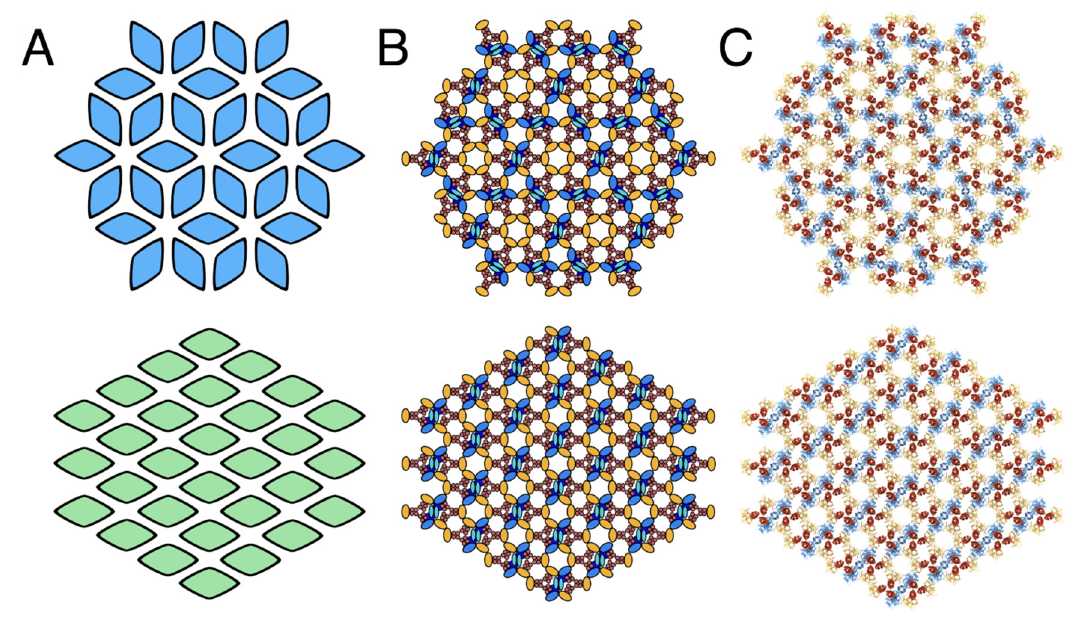
Figure 3. Schematics and models of p6 and p2 chemosensory array architectures. ( A ) Simplified schematics of p6 (top, blue) and p2 (bottom, green) array architectures with each diamond representing a CSU. ( B ) Schematics of p6 (top) and p2 (bottom) array architectures in which CheA, CheW and receptor proteins are depicted and coloured blue, green and red, respectively. ( C ) The baseplate region of all-atom models of the p6 (top) and p2 (bottom) array architectures.